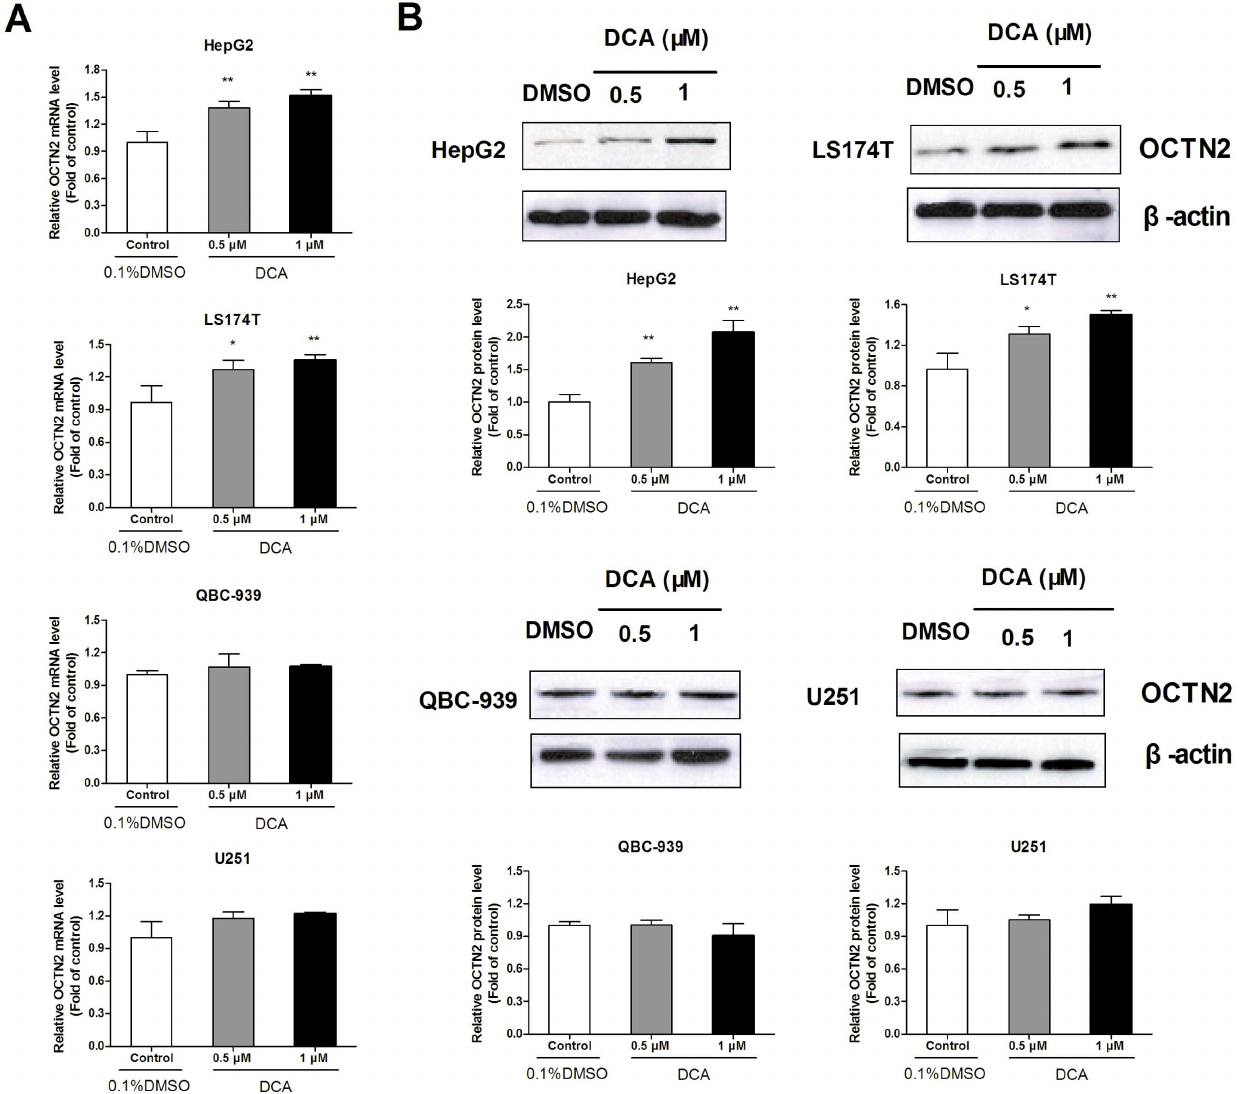
Figure 2. Effects of DCA on mRNA and protein levels of OCTN2 in cancer cell lines. (A), analysis of mRNA levels of OCTN2 in DCA-treated cancer cell lines. After treatment with 0.5 and 1 m M DCA, total RNA in cancer cells was purified by TRIzol reagent for cDNA synthesis and the mRNA levels of OCTN2 were analyzed by Quantitative RT-PCR. (B), analysis of protein levels of OCTN2 in DCA-treated cancer cell lines. Total proteins were extracted and protein levels of OCTN2 were analyzed by western blotting. The relative expression of mRNA and protein was normalized to b -actin. Data presented represent the mean 6 S.D. of three independent experiments. Significant difference from control group of 0.1% DMSO is denoted with asterisks (*, p , 0.05; **, p , 0.01). upstream and 2 kb downstream of transcriptional start site (TSS). According to the predicted CpG islands, MSP and BSP primers were designed and are listed in Table S1. Genomic DNA of cancer cell lines was isolated and DNA bisulfite modification was performed as described [20]. Bisulfite modified DNA was recovered by Wizard DNA Clean Up System (Promega) and treated with 5.5 m l of NaOH then precipitated with ethanol.